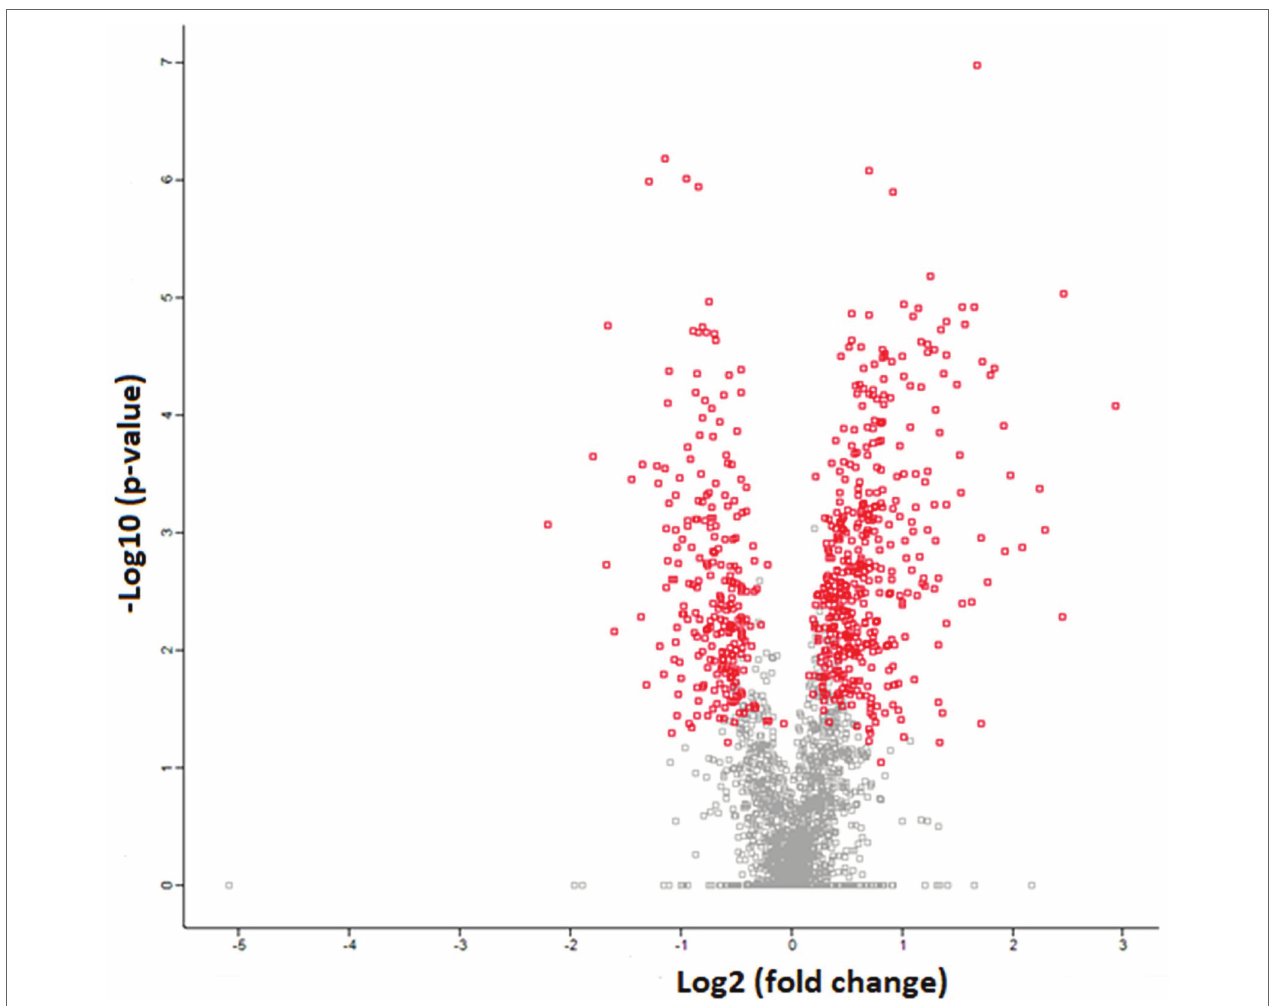
FIGURE 4 | Volcanic plot representation of Woody Breast and Normal sarcoplasmic reticulum proteome utilizing high-stringency criteria (FDR 0.05 and S0 factor 0.1) in which red dots correspond to significantly upregulated or downregulated proteins ( p < 0.05). The gray dots represent proteins that are not different ( p >